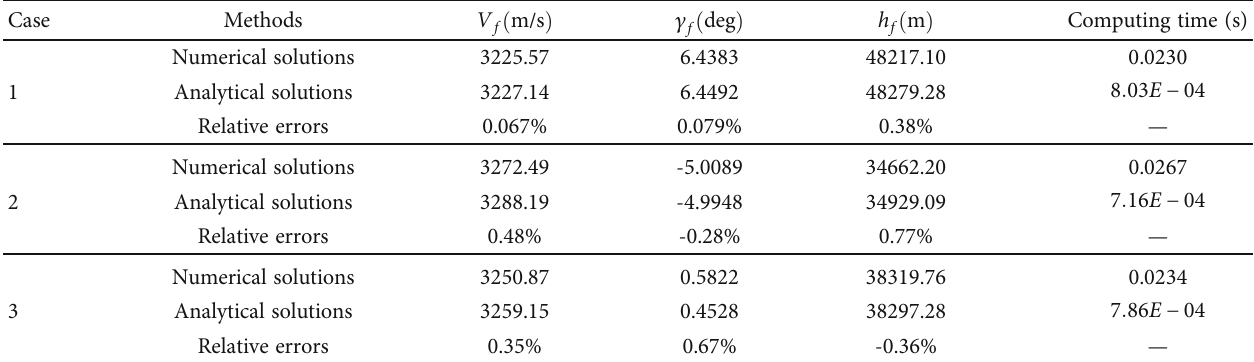
Table 3: Comparison of the analytical solutions and numerical solutions.